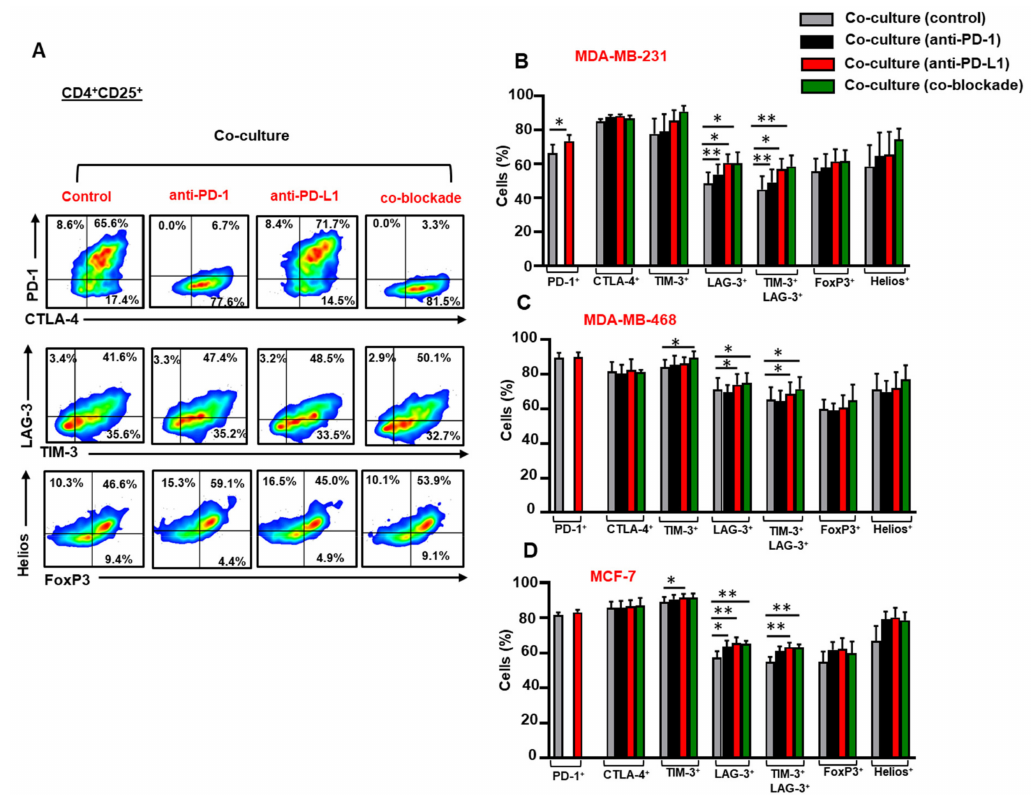
Figure 5. E ff ect of blocking PD-1 and PD-L1 on immune checkpoint and Treg-related marker expression in CD4 + CD25 + T cells. Activated PBMCs co-cultured with breast cancer cells were treated or untreated with 2 µ g / mL of anti-PD-1, 0.5 µ g / mL of anti-PD-L1 or with both mAbs. At 72 h post mAb treatment, cells were stained for immune checkpoints and FoxP3 / Helios expression, and analyzed by flow cytometry. Representative flow cytometric plots show PD-1, CTLA-4, TIM-3, LAG-3, FoxP3 and Helios expression in CD4 + CD25 + T cells from MDA-MB-231 co-culture, in the presence or absence of mAb(s) ( A ). Bar plots show the di ff erences in IC, FoxP3 and Helios expression in CD4 + CD25 + T cells in the presence or absence of MDA-MB-231 ( B ), MDA-MB-468 ( C ) and MCF-7 ( D ) cells. Data represent the mean + SEM of four independent